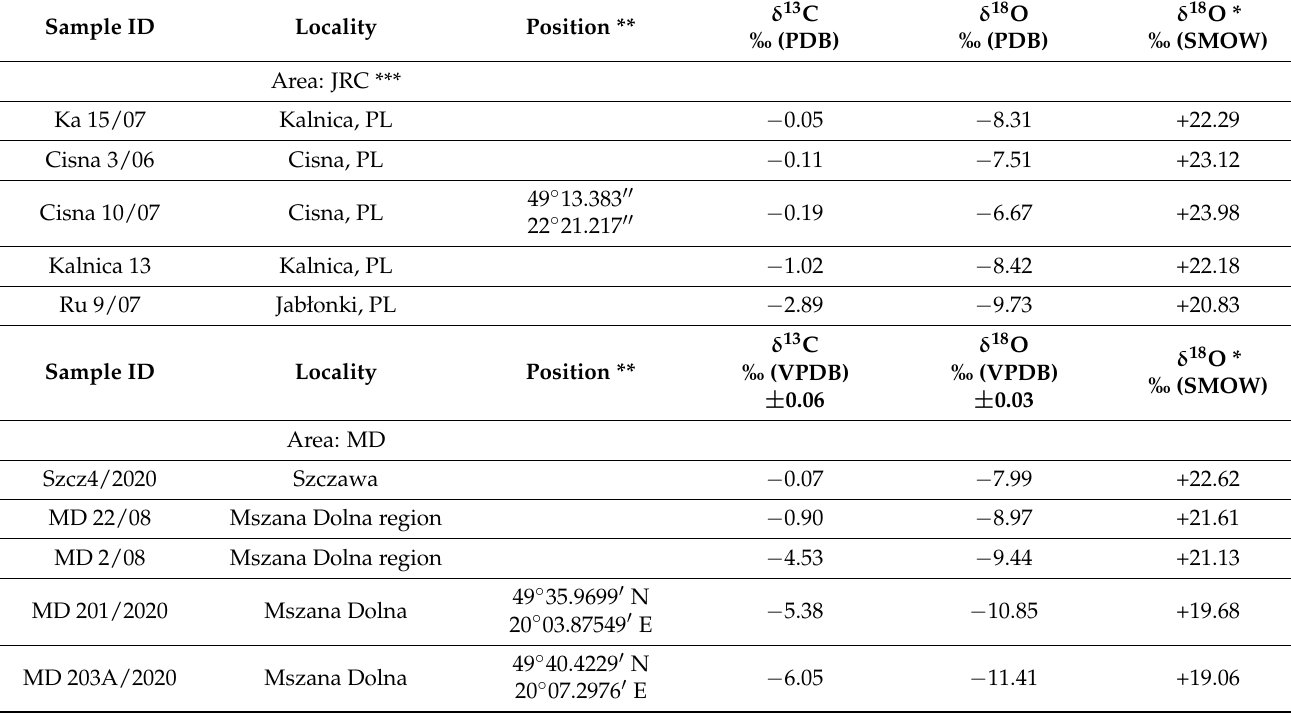
Table 3. Stable isotope results for vein calcite in JRC and